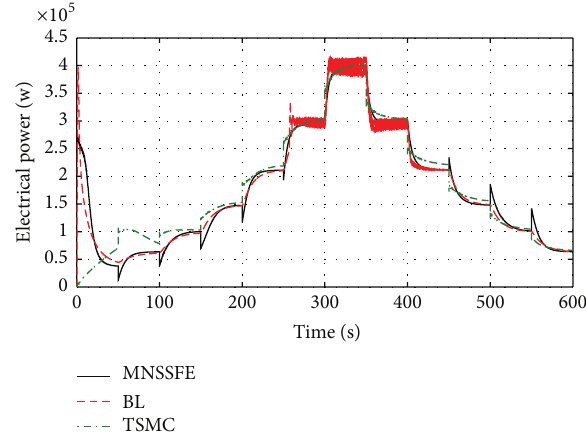
Figure 14: Comparison for baseline control with other controllers for electrical power.